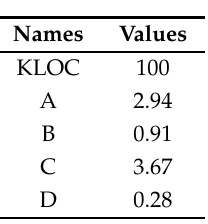
Table 6. COCOMO Regression Parameters A–D.